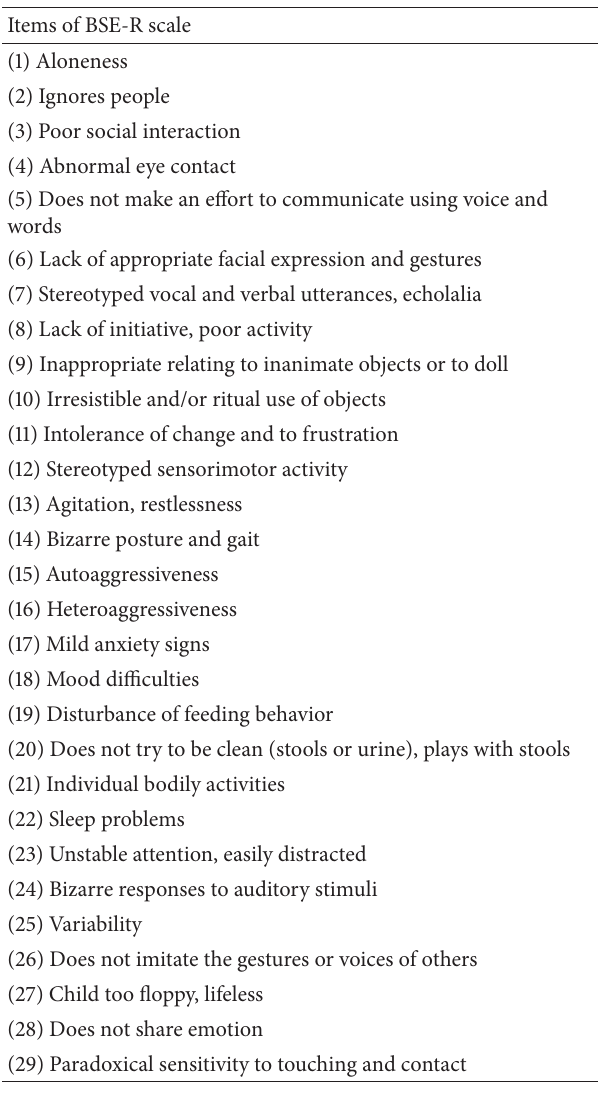
Table 2: Clinical assessments in autism group.